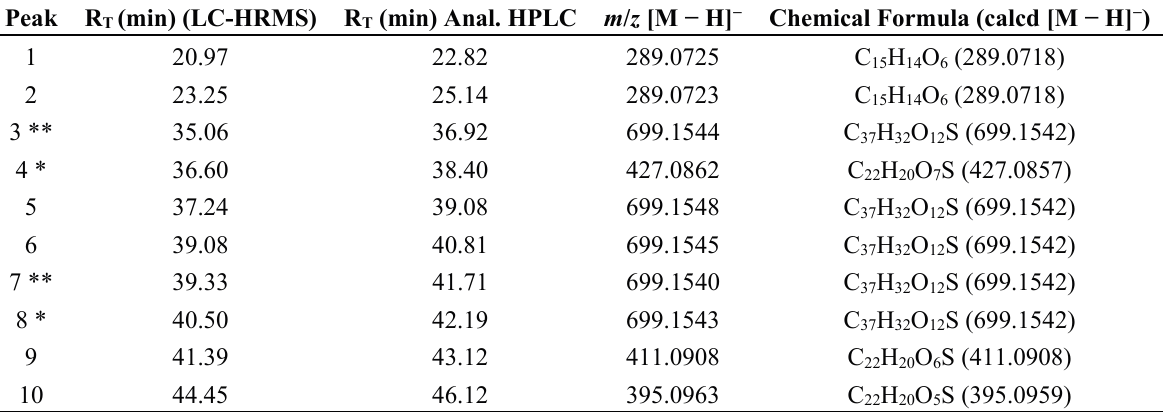
Table 1. Thiolysis related